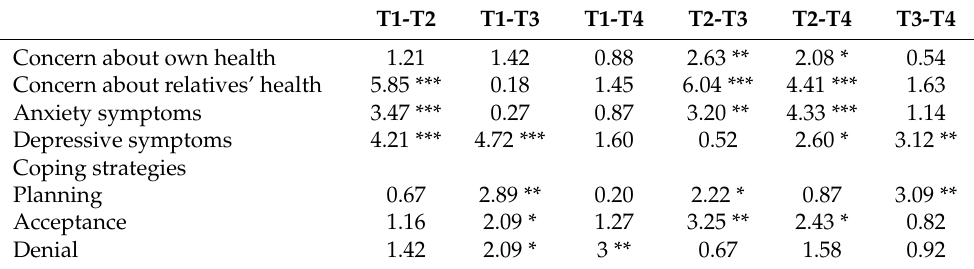
Table 3. Comparisons of coping strategies, health concerns and anxiety–depressive symptoms scores of French students between each measurement time with Conover’s Post-Hoc test (N =